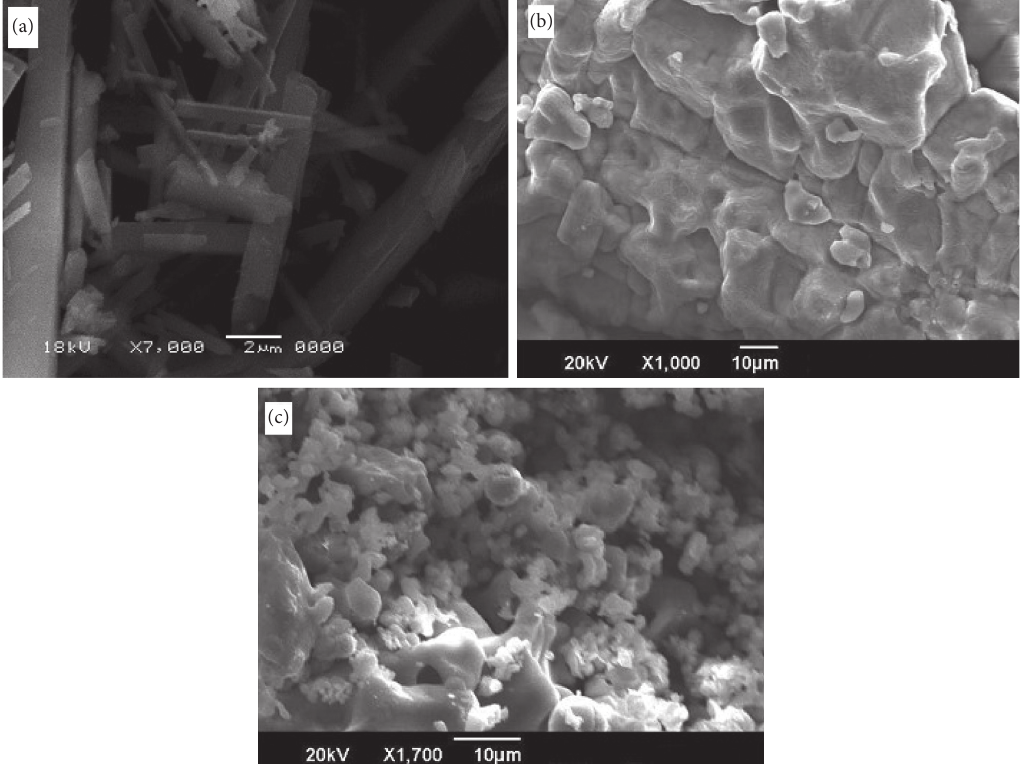
Figure 7: SEM images of (a) Ga(III), (b) Ge(IV), and (c) Hf(IV) folate